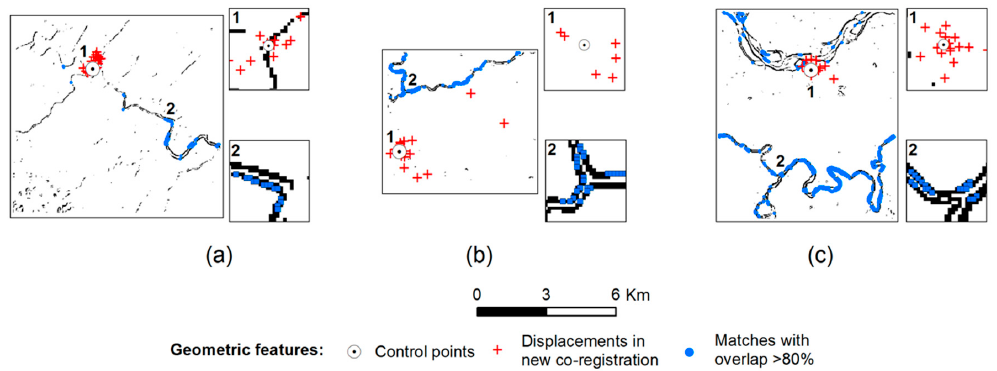
Figure 3. Edge mask from reference image (November 2000) and control, displacements, and matching points with overlap greater than 80% in the: ( a ) Study area A, ( b ) Study area B, and ( c ) Study area